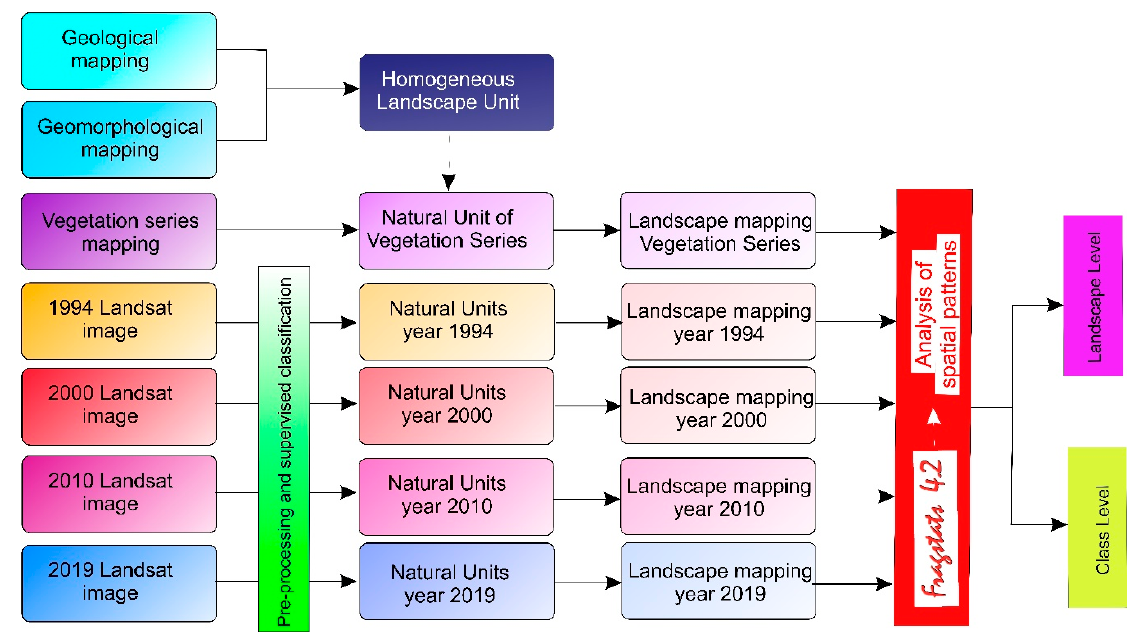
Figure 2. General methodology.